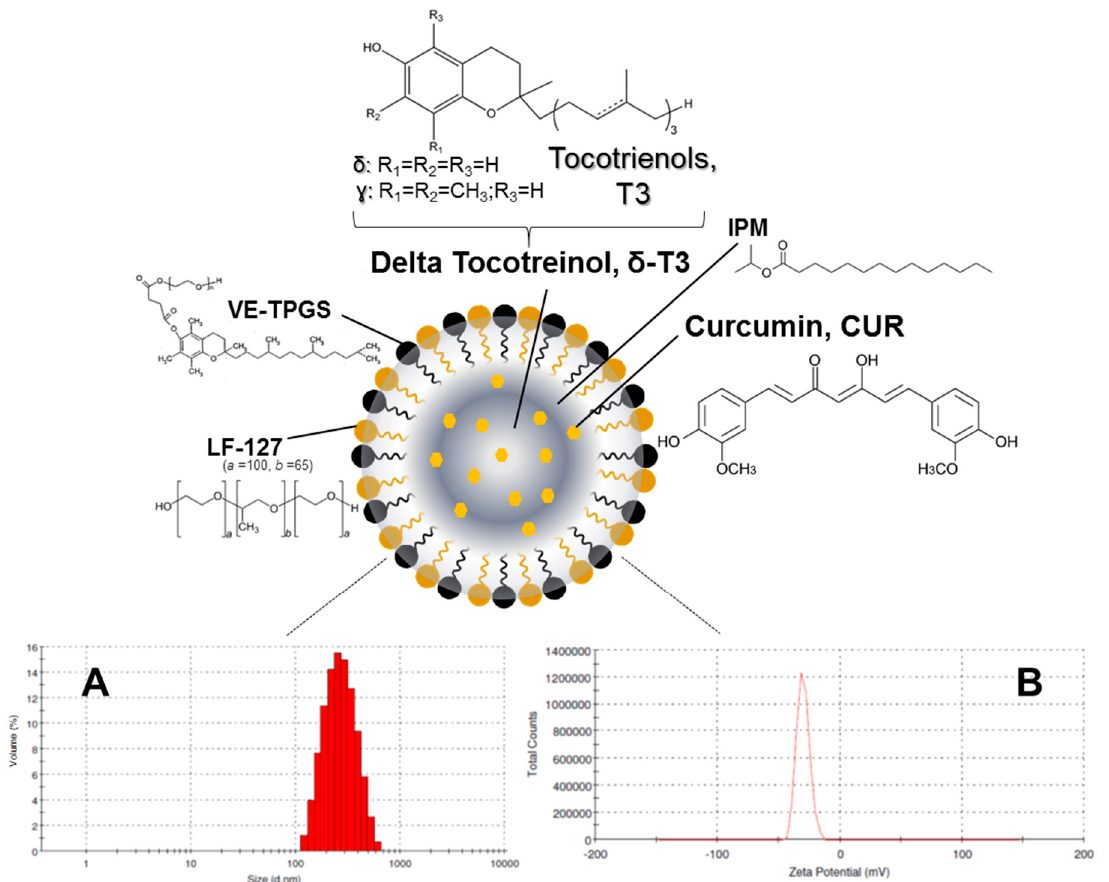
Figure 1. Schematic diagram of tocotrienol nanoemulsion platform of curcumin illustrating the chemical structures of both components of surfactant mixture, Lutrol ® F127and Vitamin E TPGS, along with those of the core oil phase, curcumin, and isopropyl myristate. Plus, representative analysis of prototype δ -tocotreinol nanoemulsion loaded with 1.96 ± 0.37 mg/mL of curcumin ( n = 3), showing mean ( A ) droplet size; and ( B ) interfacial electrical charge (measured as ζ -potential).